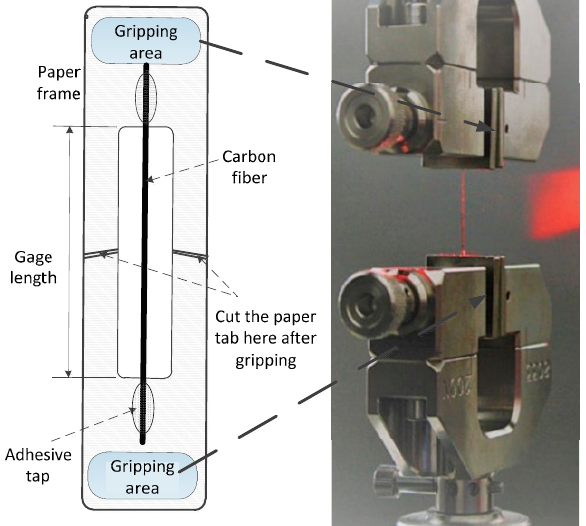
Figure 2. Single fiber specimen for axial tensile testing.